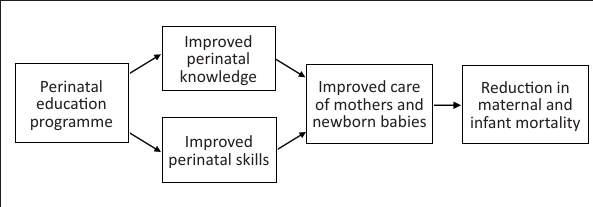
FIGURE 1: Programme theory of the perinatal education